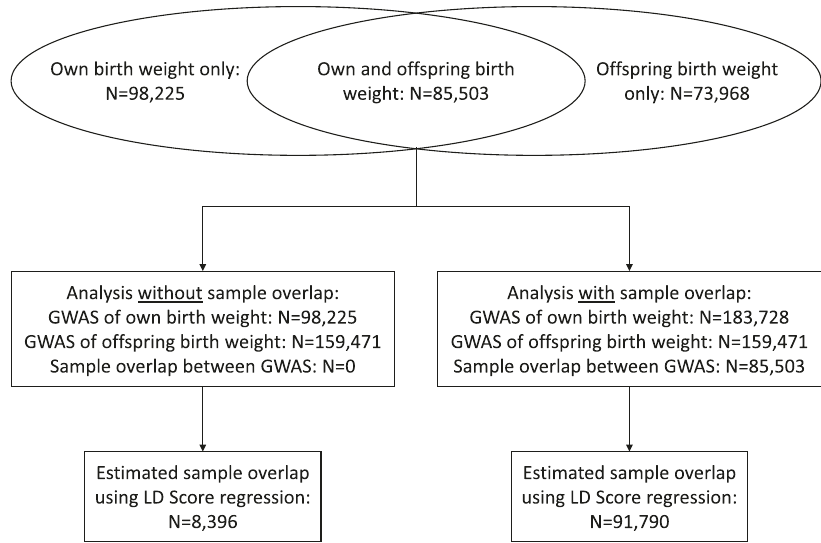
Fig. 4 Schematic of the study design for comparing methods using self-reported birth weight data from the UK Biobank. We conducted two sets of analysis, one with and one without sample overlap between the genome-wide association studies (GWAS), to investigate the effect of sample overlap in each of the